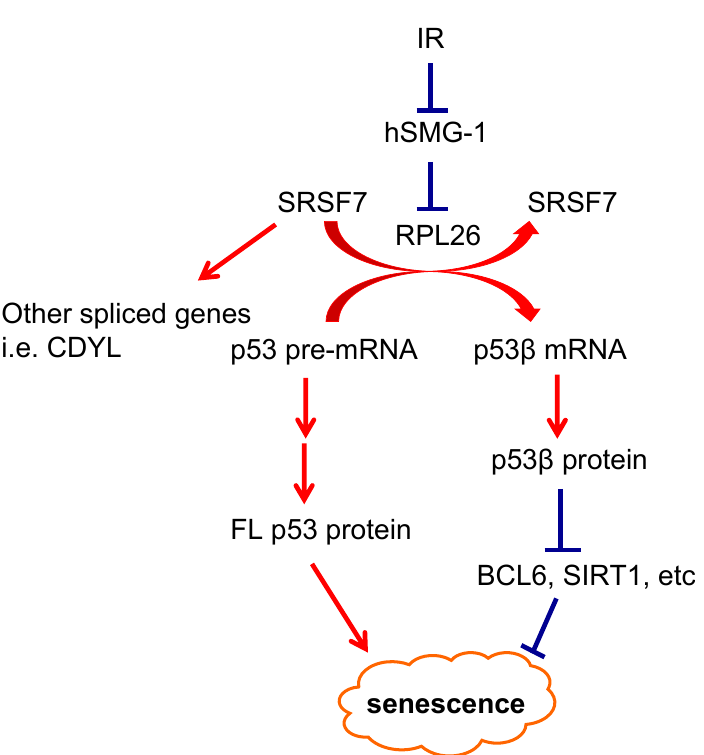
Figure 1. Schema of the new arm of the DNA damage signaling pathway (DDR). Irradiation (IR) suppresses hSMG1 kinase activity, inactive hSMG1 releases from p53 pre-mRNA and allows ribosomal protein L26 (RPL26)–SRSF7 to bind, resulting in splicing to generate p53 β . p53 β is indispensable for induction of senescence markers after IR, perhaps through transcriptional repression. (Adapted from Chen et al., Cancer Discovery, 2017